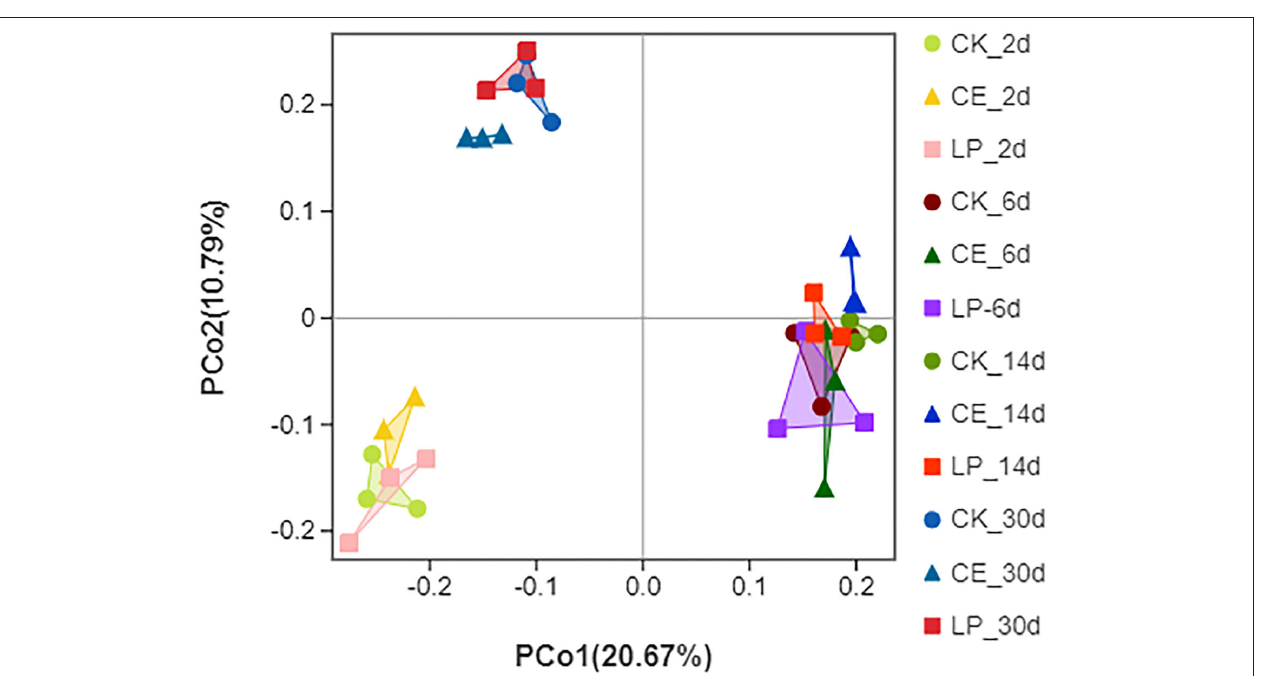
The 2- and 30-day CA silages were clustered in the third and second quadrants, whereas both the 6- and 14-day silages were in the first and fourth quadrants,